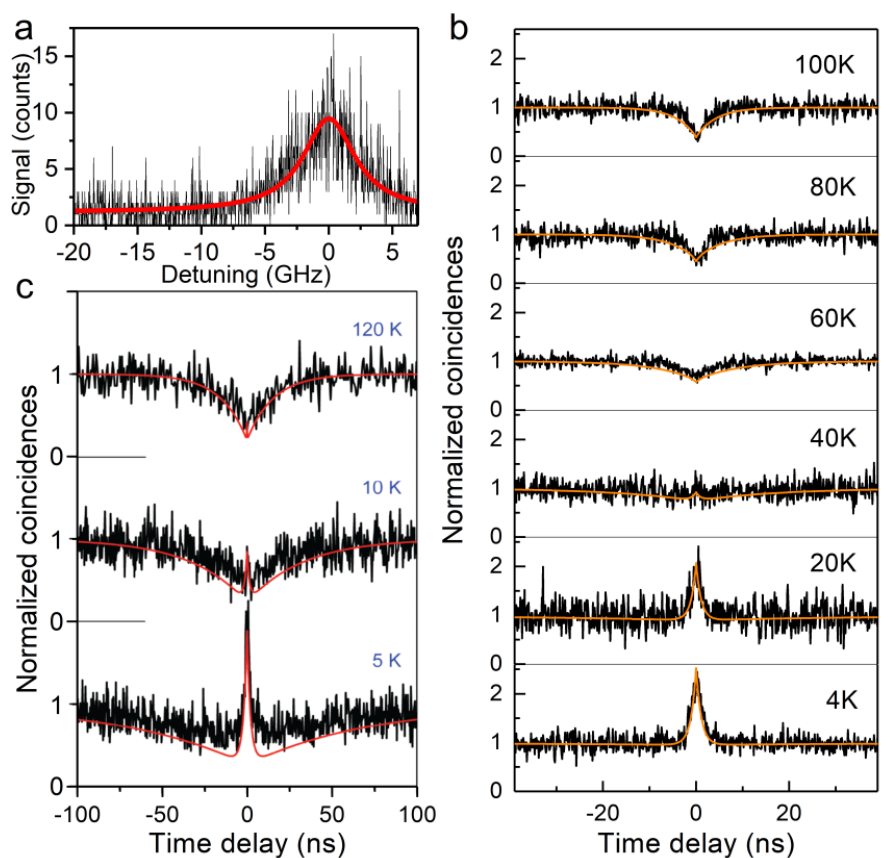
Figure 6. Tunable photon statistics of single quantum dots. ( a ) Resonant PL excitation spectrum of a single CsPbI 3 NC. It is fitted with a Lorentzian profile with a line width of 5 GHz FWHM (red curve). ( b , c ) Normalized photon coincidence histograms of a single CsPbI 3 NC ( b ) and a CdSe NC ( c ) at various temperatures, showing a similar conversion from bunching to antibunching as the dark and bright exciton sublevels become thermal mixed. The red curves are numerical simulations of the PL autocorrelation function on the basis of a four-level model [40]. Adapted from ref. [40].